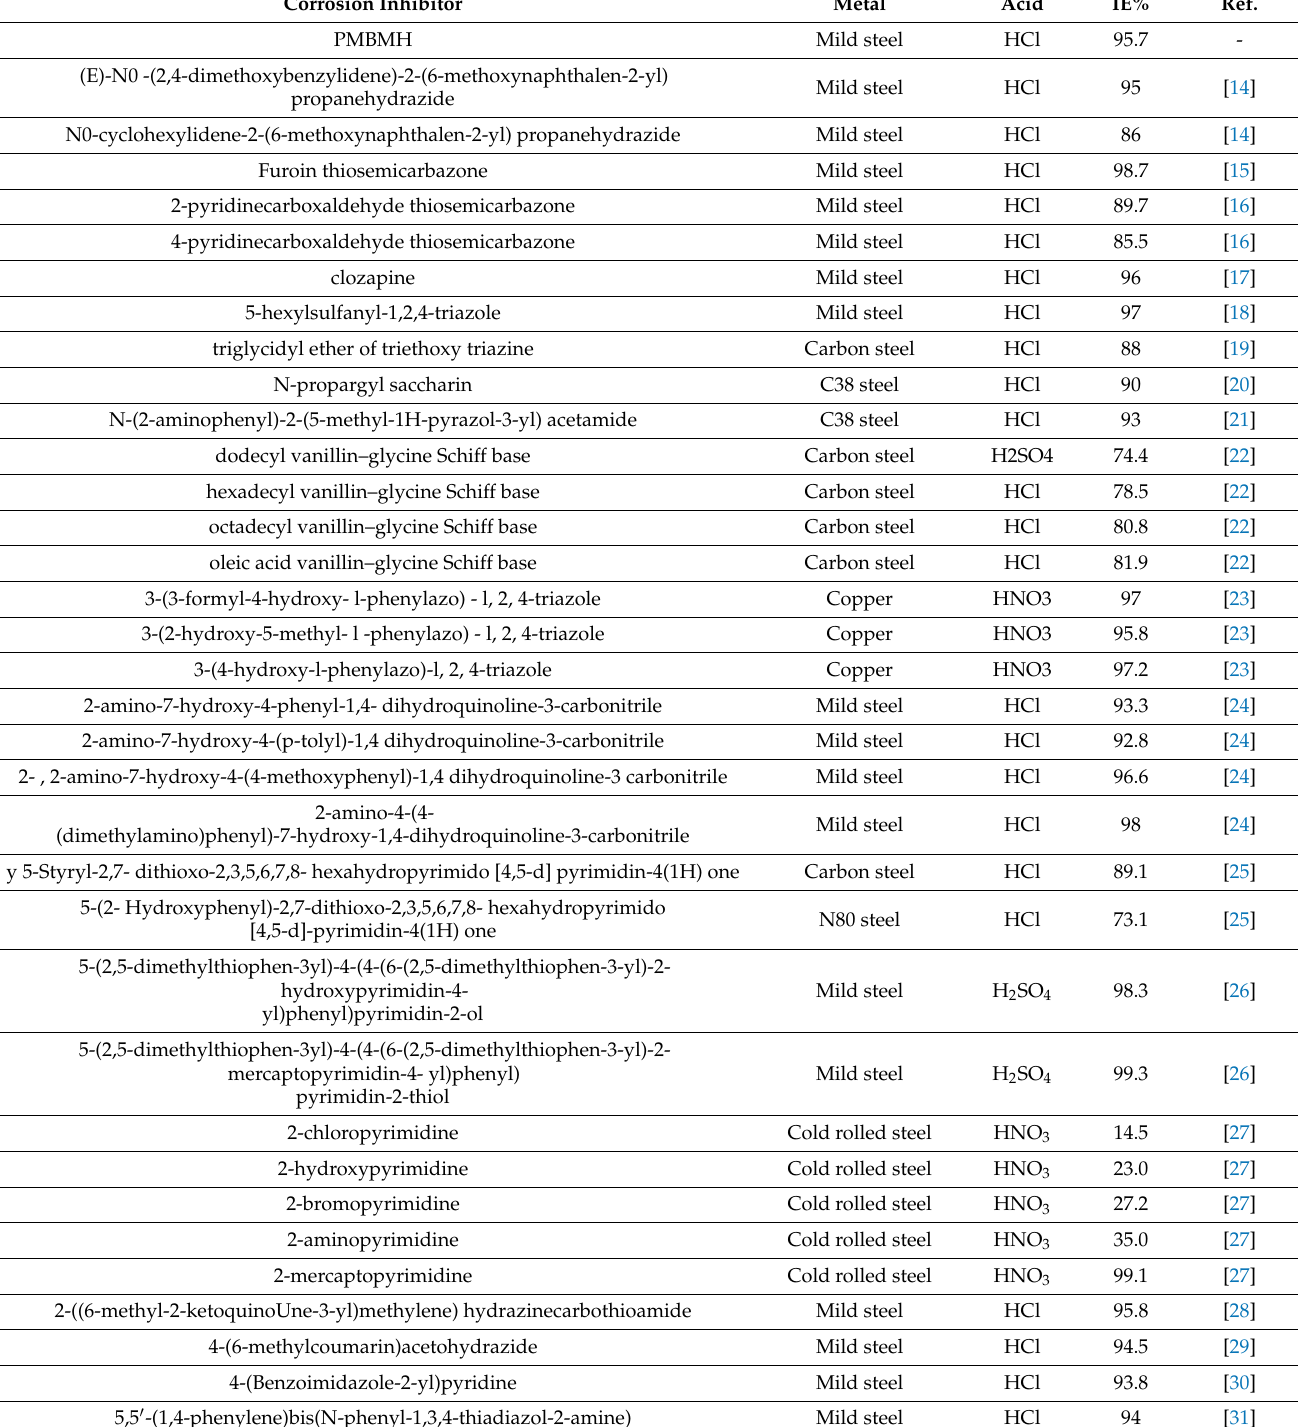
finding indicates that the increase in temperature did not enable physical interactions (physisorption), which resulted in a reduction in the protective efficacy. Table 1. PMBMH inhibition was statistically compared to the efficacy of other heterocyclic organic inhibitors that had previously been